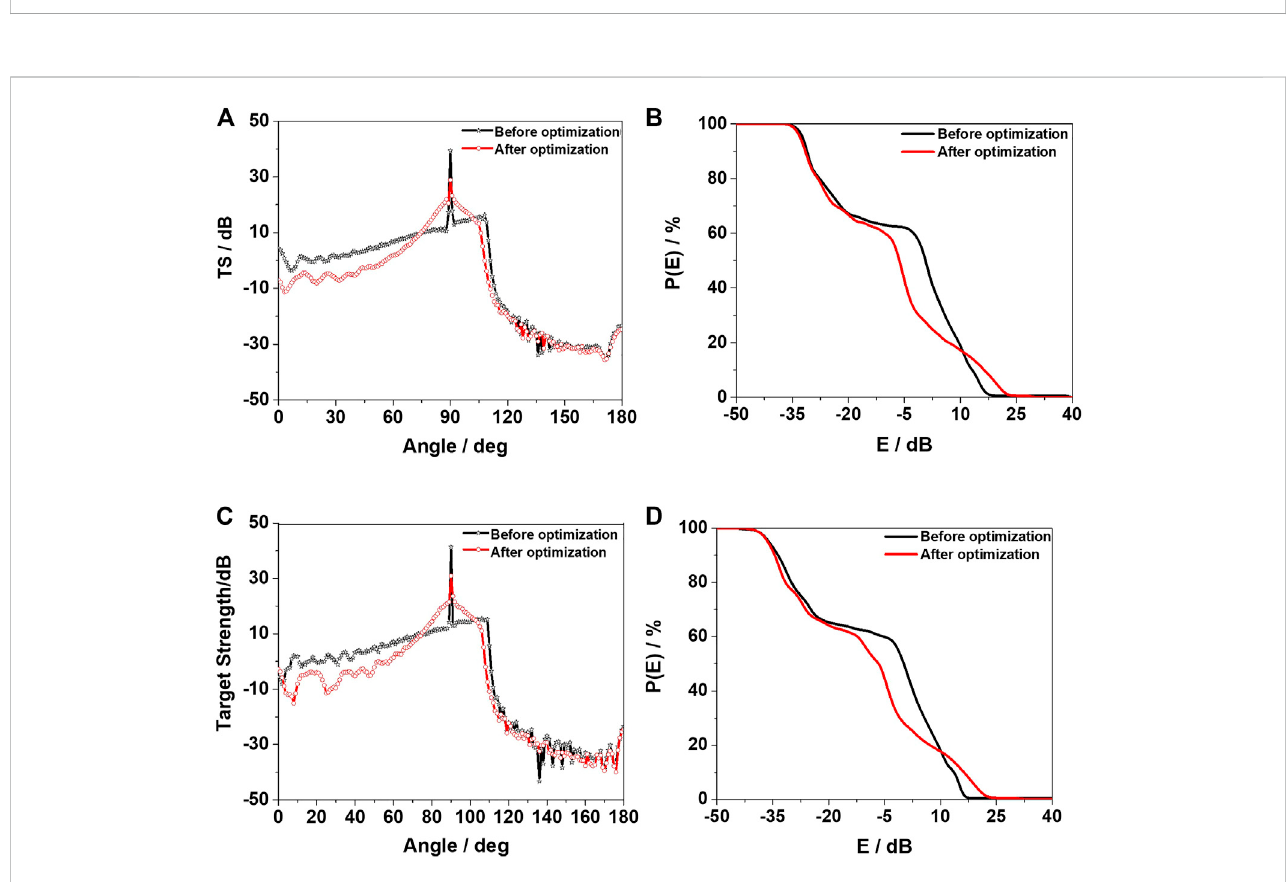
FIGURE 8 Azimuth characteristics and detection rate with respect to angle of the TS of the hull before and after optimization. (A,B) are f = 5.0 kHz. (C,D) are f = 10.0